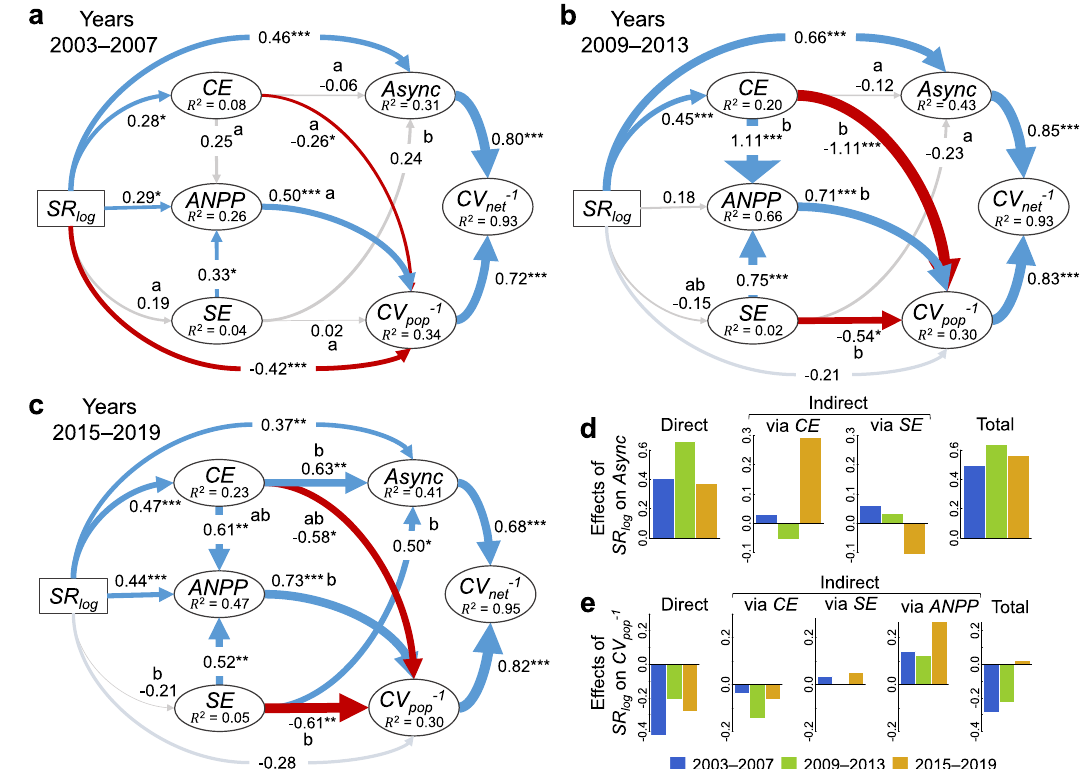
Fig. 4 | Linking temporal changes in biodiversity effects with stability over threenon-overlapping5-yearwindows. Thestructuralequationmodelshowsthe species richness (SR log ) effects on the 5-year community productivity (ANPP) and indirectly through the 5-year complementarity (CE) and selection (SE) effects that together affect species population stability (CV pop − 1 ) and asynchrony (Async). Standardized path coef fi cients are indicated by arrows with signi fi cant positive effects in blue and negative in red. Signi fi canceisindicated by * P <0.05, ** P <0.01,